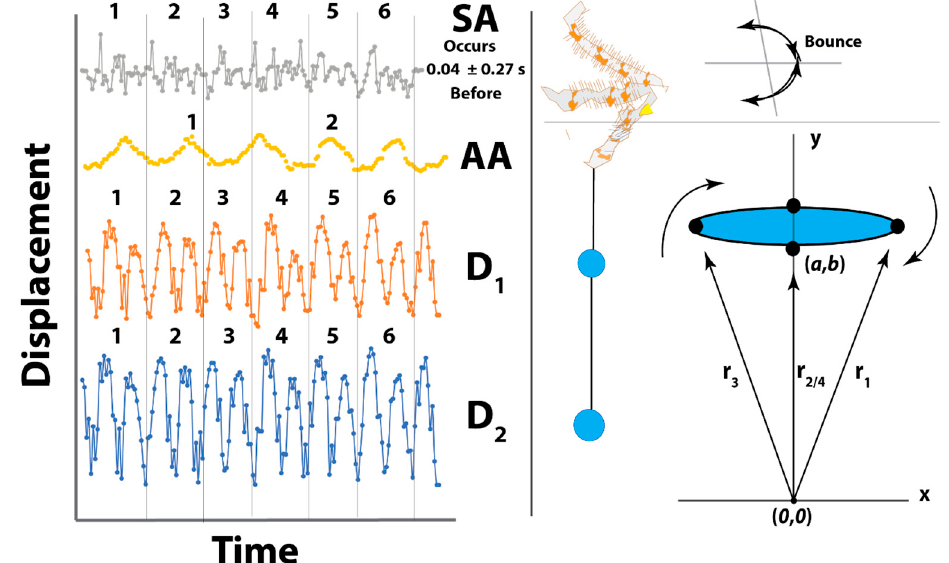
Figure 5. Leg and Glue Droplet Rotational Phase Alignment. Because all distances were measured as vectors radiating from a common origin, rotational periods are shown as two maxima, as the maximum displacement occurs twice. The second rotation or the second half of the circle is always shorter and slower, meaning that the energy the spider is putting into the thread is falling off almost instantly. Thus, two peaks show the period, and the rotational diameter is the maximum displacement of both peaks combined. Calculating the frames between distances, we found that the displacement of droplet two (D 2 ) was always higher than droplet one (D 1 ) but D 1 , D 2 , and the swing leg (SA) were nearly perfectly in sync. The maximum displacement of the SA always occurred two frames or 0.04 s before the droplets, meaning it was using its body to accelerate the glue droplets. The SA does not have two peaks because the spider is not completing a full rotation, but instead is thrusting forward and bouncing back. The period of the anchor leg (AA) was always twice as long as the other periods.